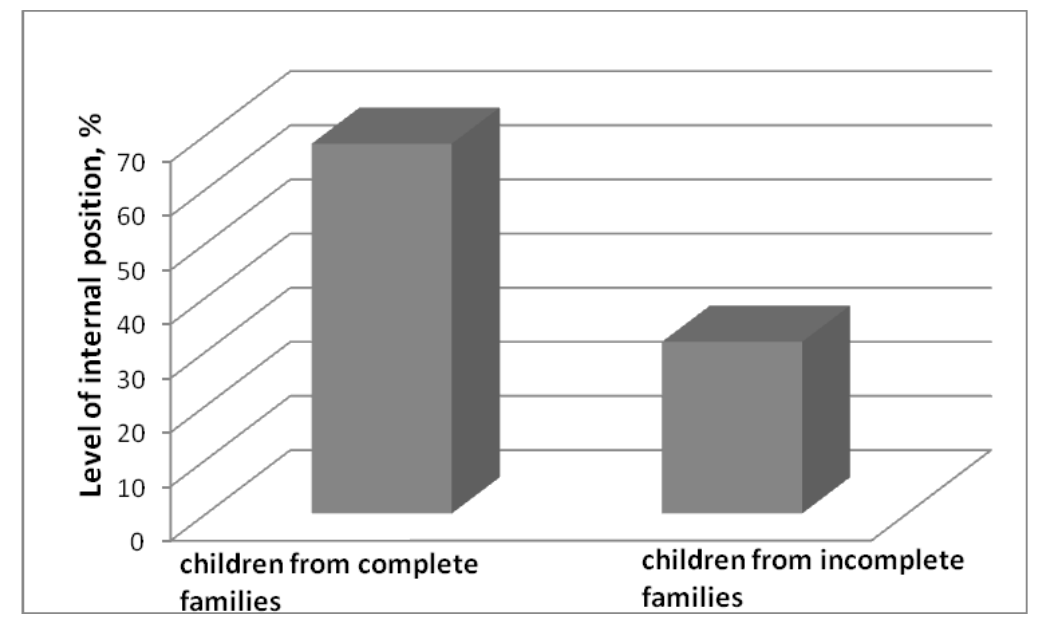
Fig 1. Differences of forming internal position of the student in children with nuclear and single parent families according to method “Two schools” by Leonid Venger.